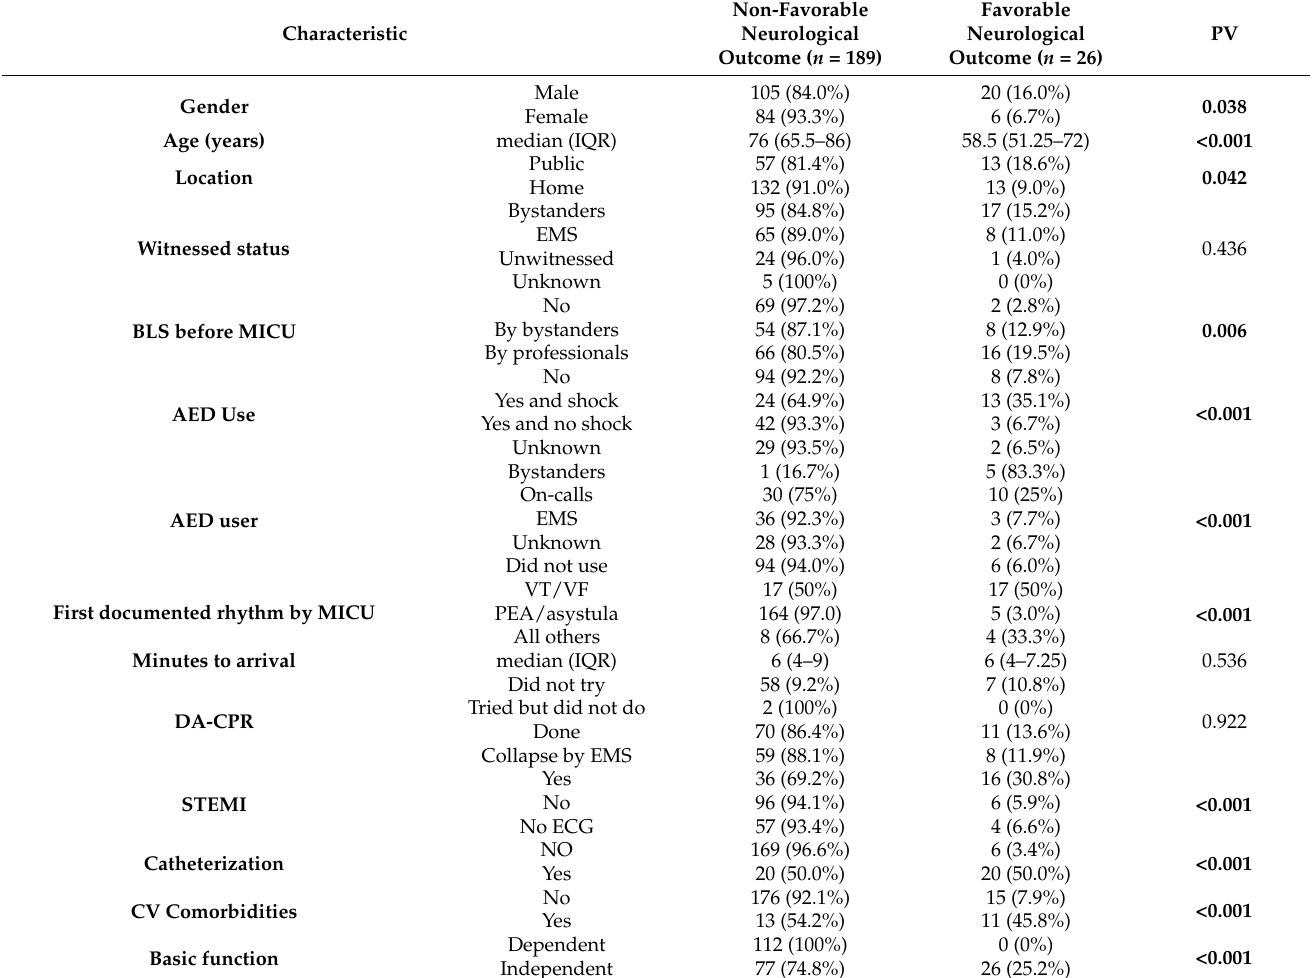
Table 5. Crude neurological outcome according to patients’ characteristics and prehospital and hospital